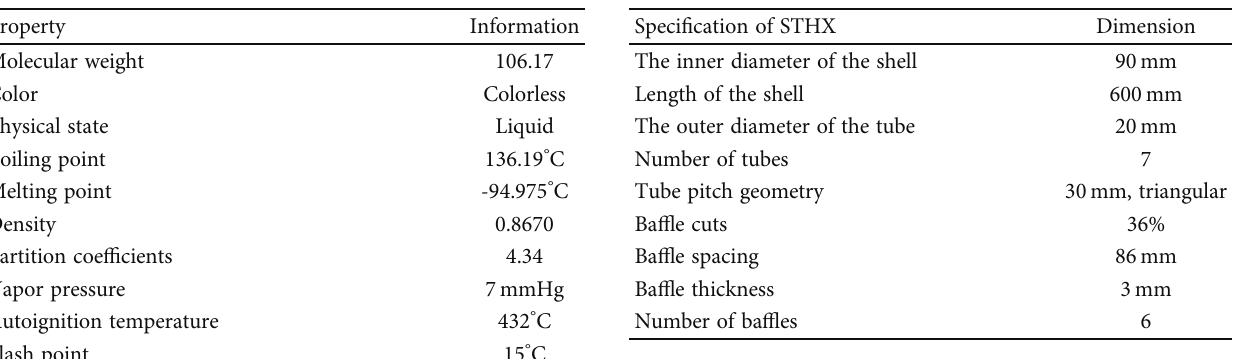
Table 1: Physical and chemical properties of ethylbenzene.